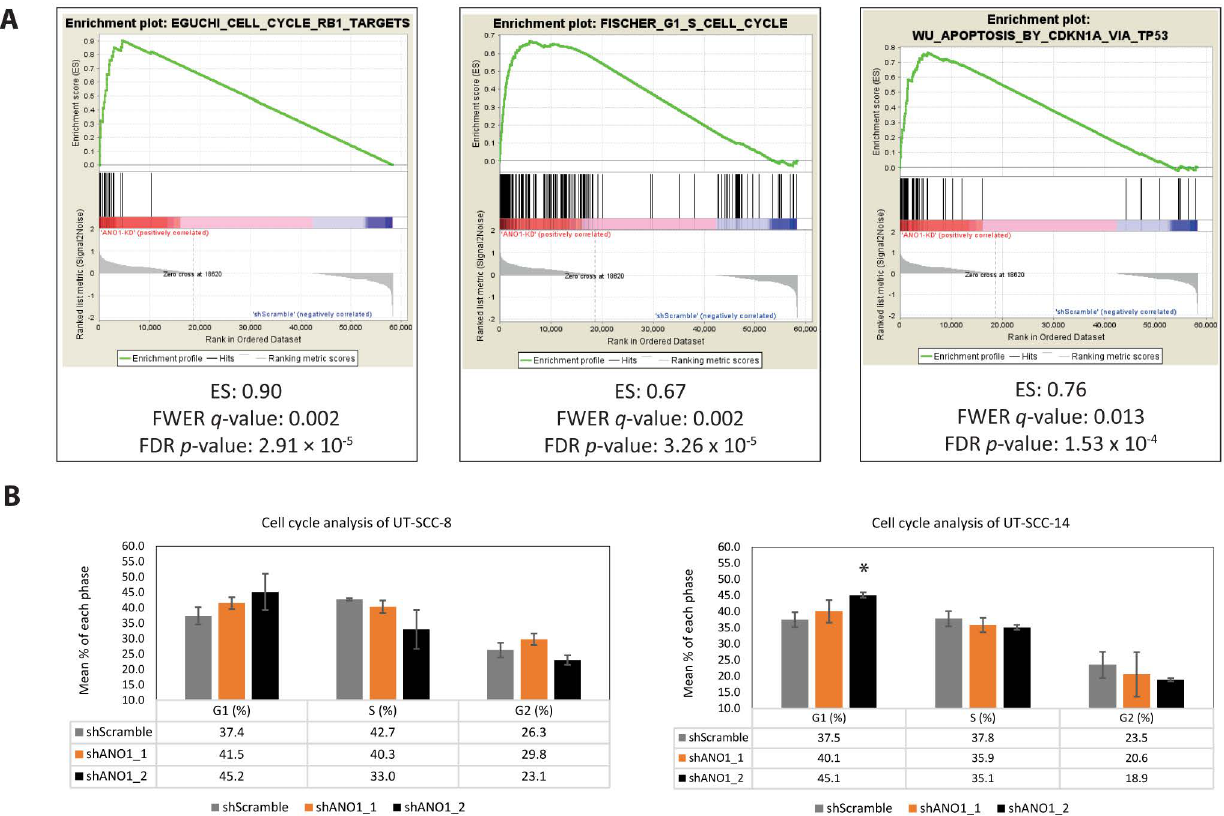
Figure 3. Gene Set Enrichment Analysis (GSEA) pathway analysis revealed ANO1 involvement in multiple cell cycle-related pathways. ( A ) Representative plots of significantly enriched pathways derived from the GSEA analysis. Criteria values for the selection were enrichment score (ES), family-wise error rate (FWER, q -value) < 0.025, and false discovery rate (FDR) < 0.05. ( B ) Bar plot graphs illustrating the mean percentage distribution of UT-SCC-8 and UT-SCC-14 shScramble, shANO1_1 and shANO1_2 cells in G1, S and G2 phases, respectively, *: p -value <